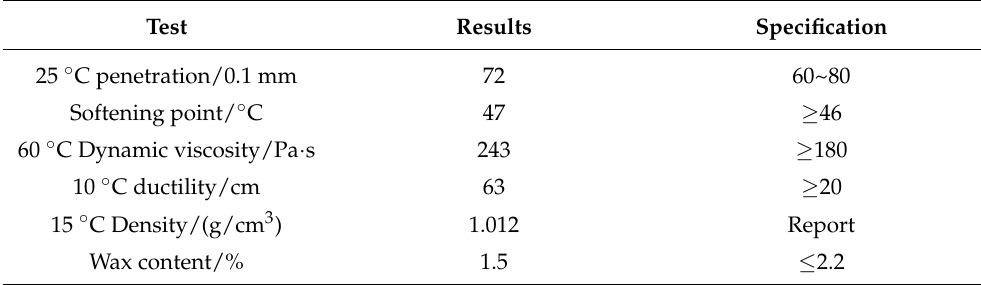
Table 3. Test results of the technical performance of matrix